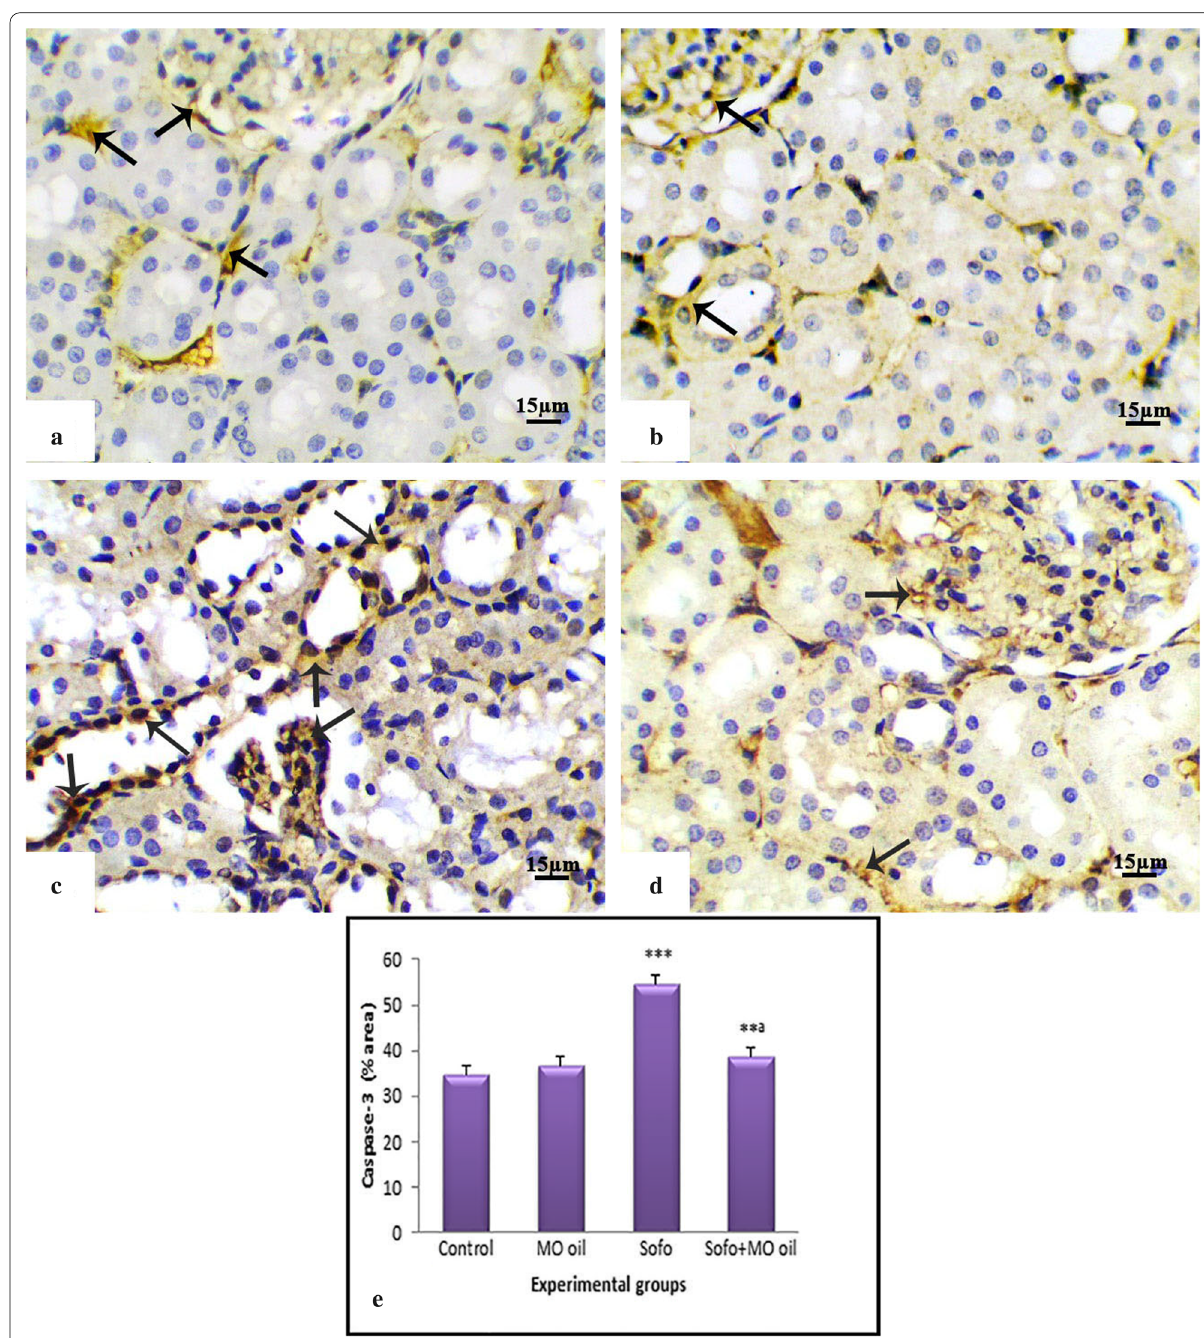
Fig. 5 Photomicrographs obtained from kidney sections of a control rat showing normal caspase-3 expression as brown color in the cytoplasm of few glomerular and tubular cells (arrows), b MO oil-treated rat showing normal expression of caspase-3 in the cytoplasm of few cells (arrows), c sofo-treated rat showing caspase-3 expression in the cytoplasm of large number of glomerular and tubular cells (arrows), d sofo- and MO oil-treated rat showing caspase-3 expression in the cytoplasm of few numbers of glomerular and tubular cells (arrows), (caspase-3 immunostain, counterstained with hematoxylin, X 400). e The percentage area of caspase-3 expression in the different experimental groups. ( ⁎⁎ ) p < 0.001 and ( ⁎⁎⁎ ) p < 0.0001significant comparing with control group. ( a ) p < 0.0001 significant comparing with sofo